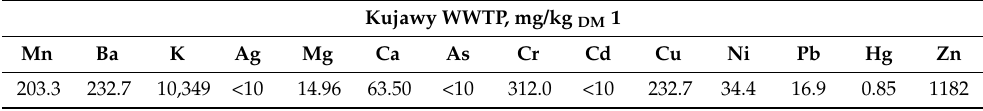
Table 1. Content of metals in digested sludge; arithmetic mean of three